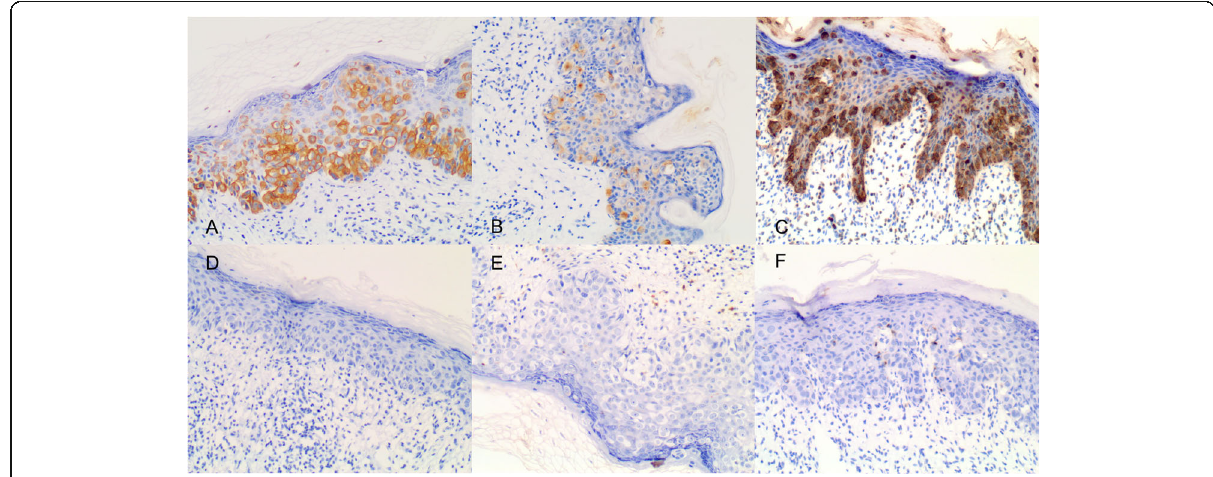
Fig. 3 Immunohistochemical staining of the axillary Paget disease lesion (100× magnification). A Positive staining for CK7; B Weakly positive staining for GCDFP15; C Positive staining for CEA; D Negative staining for CK20; E Negative staining for S100; F Negative staining for